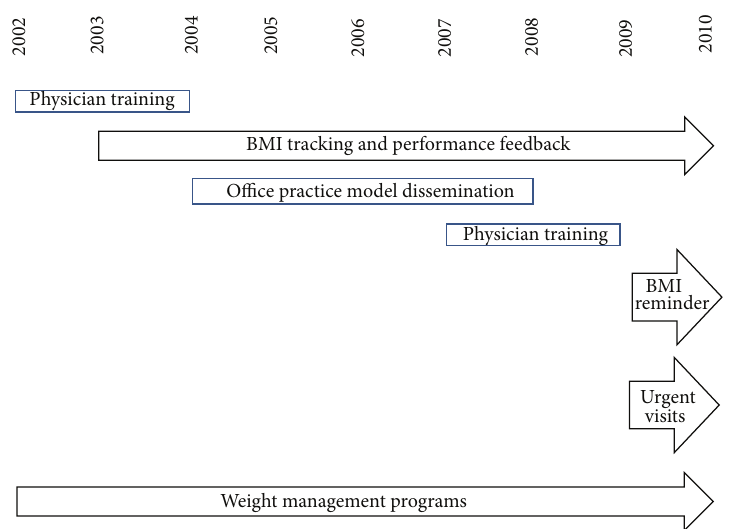
Figure 2: KPNC strategies to address childhood obesity.